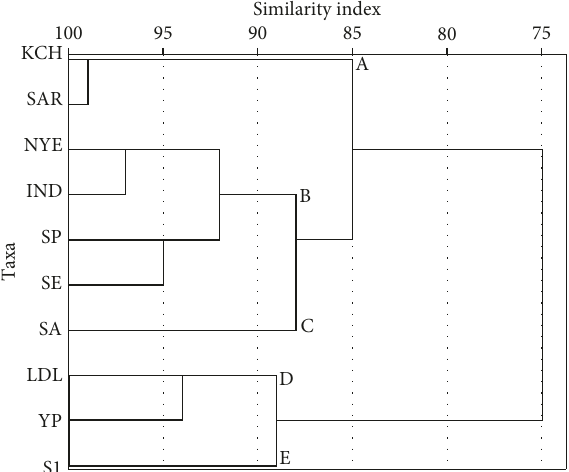
Figure 17: Seed weight (10